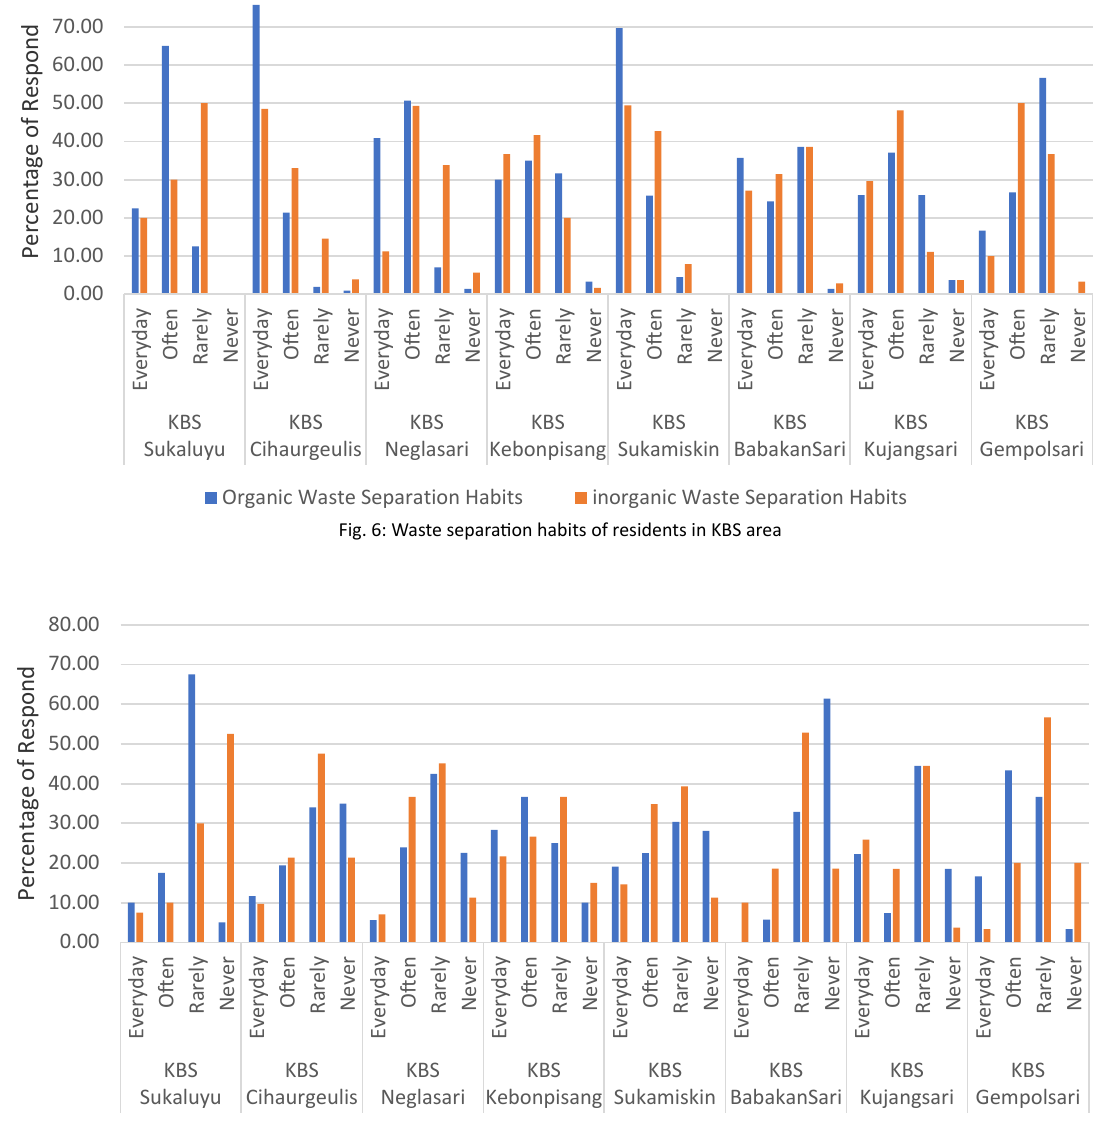
Fig. 7: Waste recycling habits of residents in KBS area